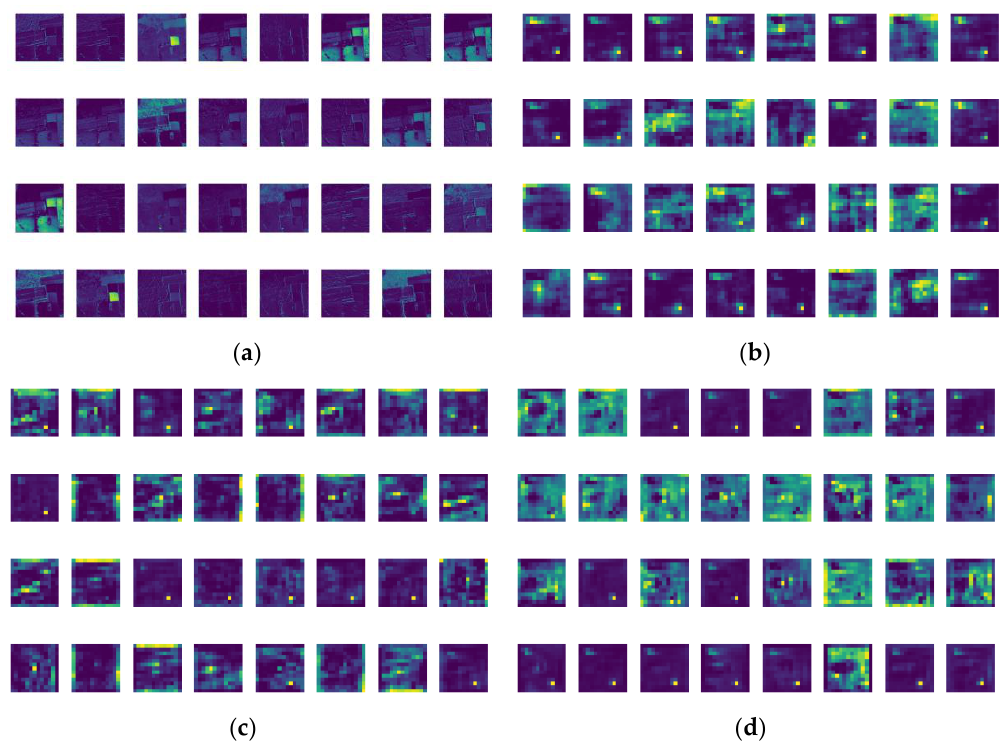
Figure 17. Visualization of the feature maps. ( a ) The feature maps of the first layer; ( b ) The feature maps of the Vision Transformer layer; ( c ) The feature maps of the BiFPN structure; ( d )The feature maps of the output layer.